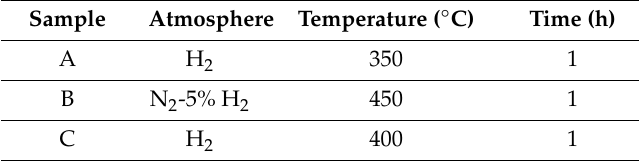
Table 1. Conditions for reductive annealing of polyol-derived Fe-glycolate